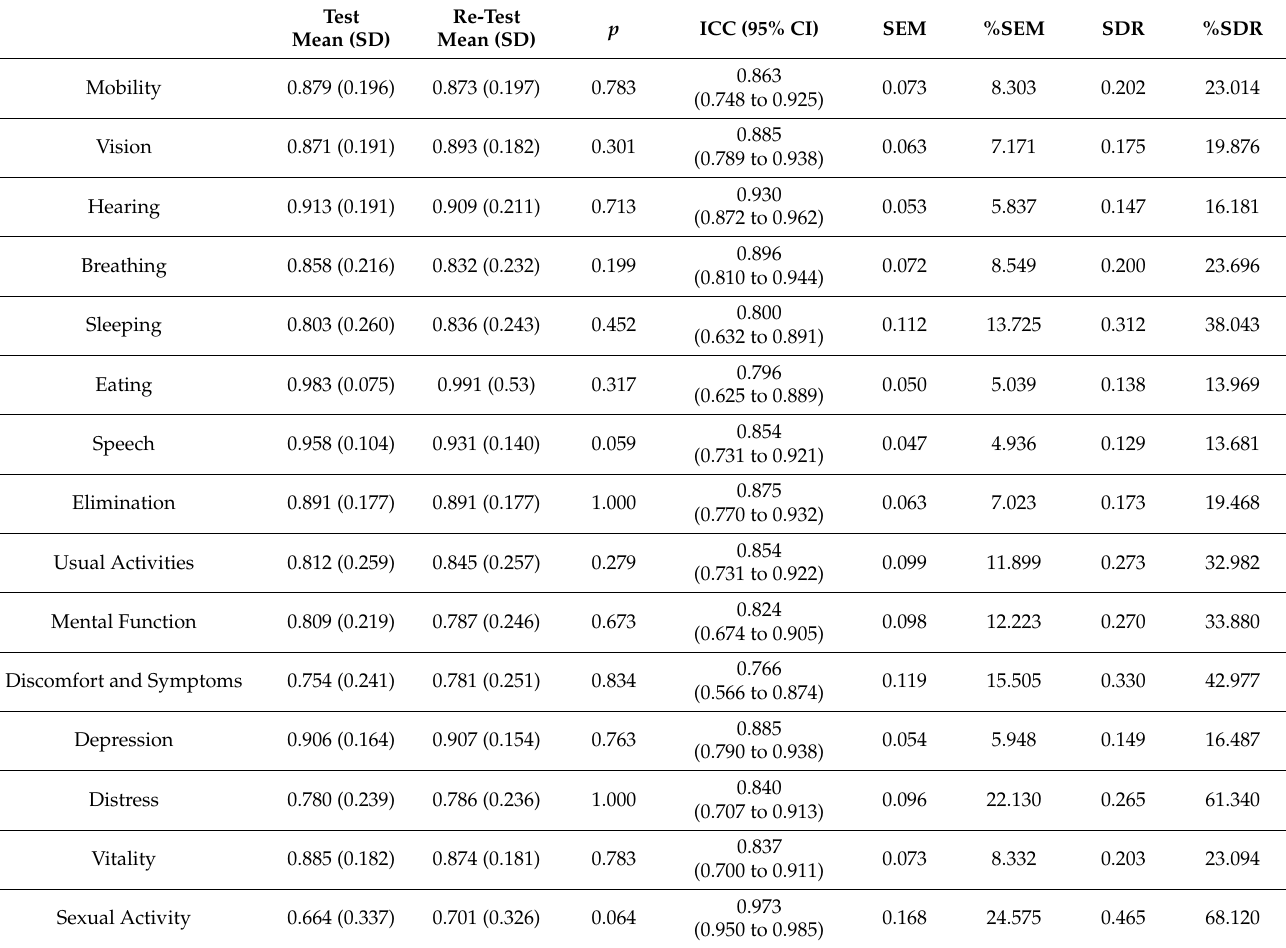
Table 4. Mean and Standard Deviation, Reliability and Internal